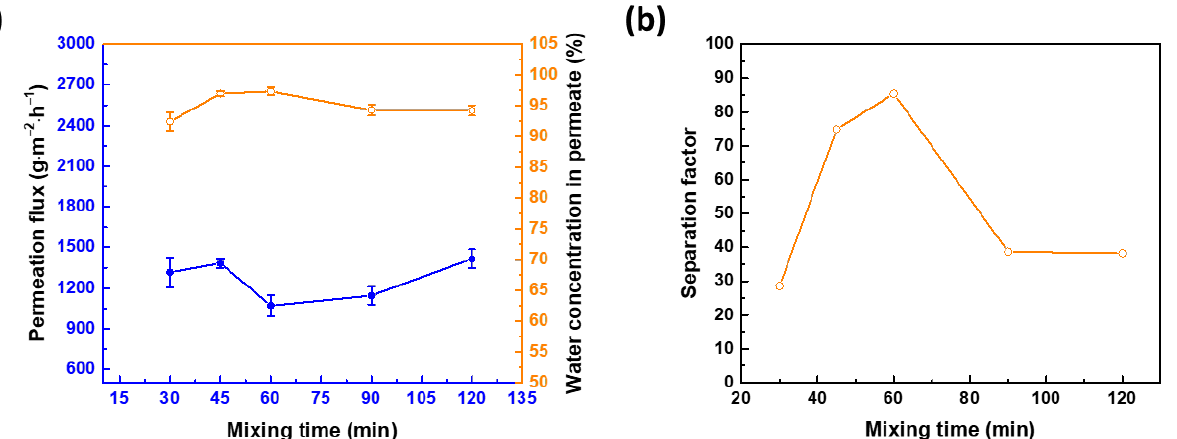
Figure 7. Effect of APTMOS and CHDA mixing time on pervaporation membrane performance, as a function of ( a ) permeation flux and water concentration in permeate and ( b ) separation factor. APTMOS/CHDA ratio = 0.15; reaction temperature = 30 °C; concentration of IPA = 70 wt%; downstream pressure = 1 mmHg; and operating temperature = 25 °C.